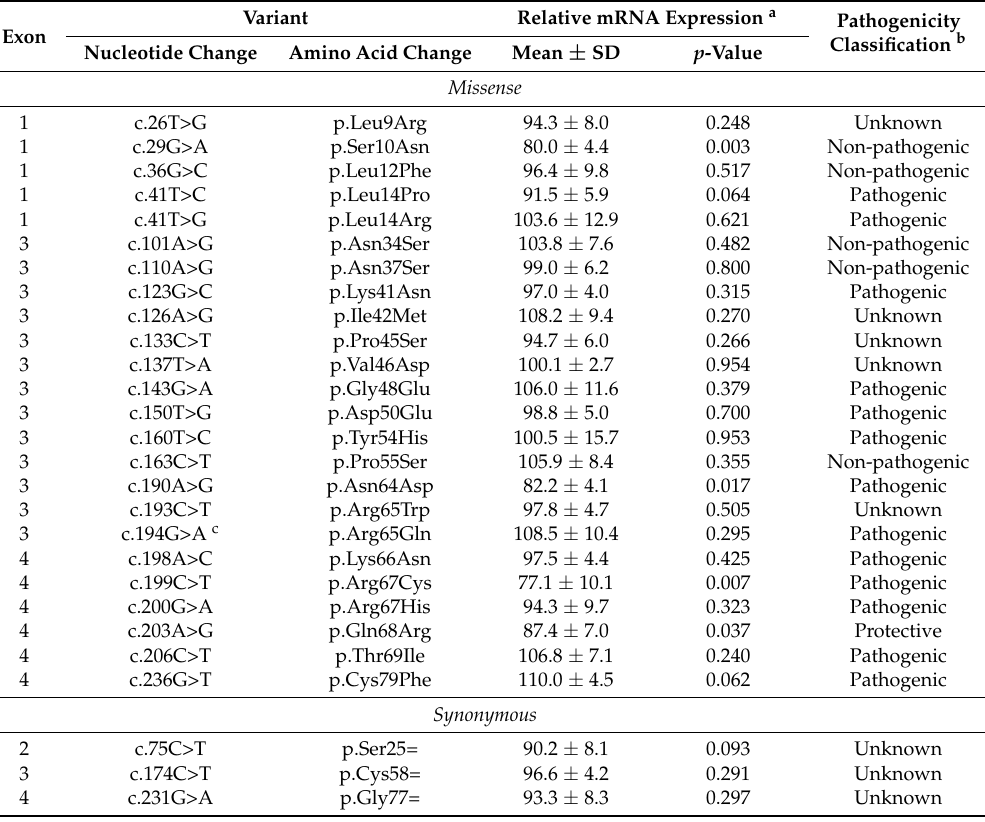
Table 1. Quantitative reverse-transcription PCR (RT-PCR) analyses of mRNA expression from HEK293T cells transfected with SPINK1 missense